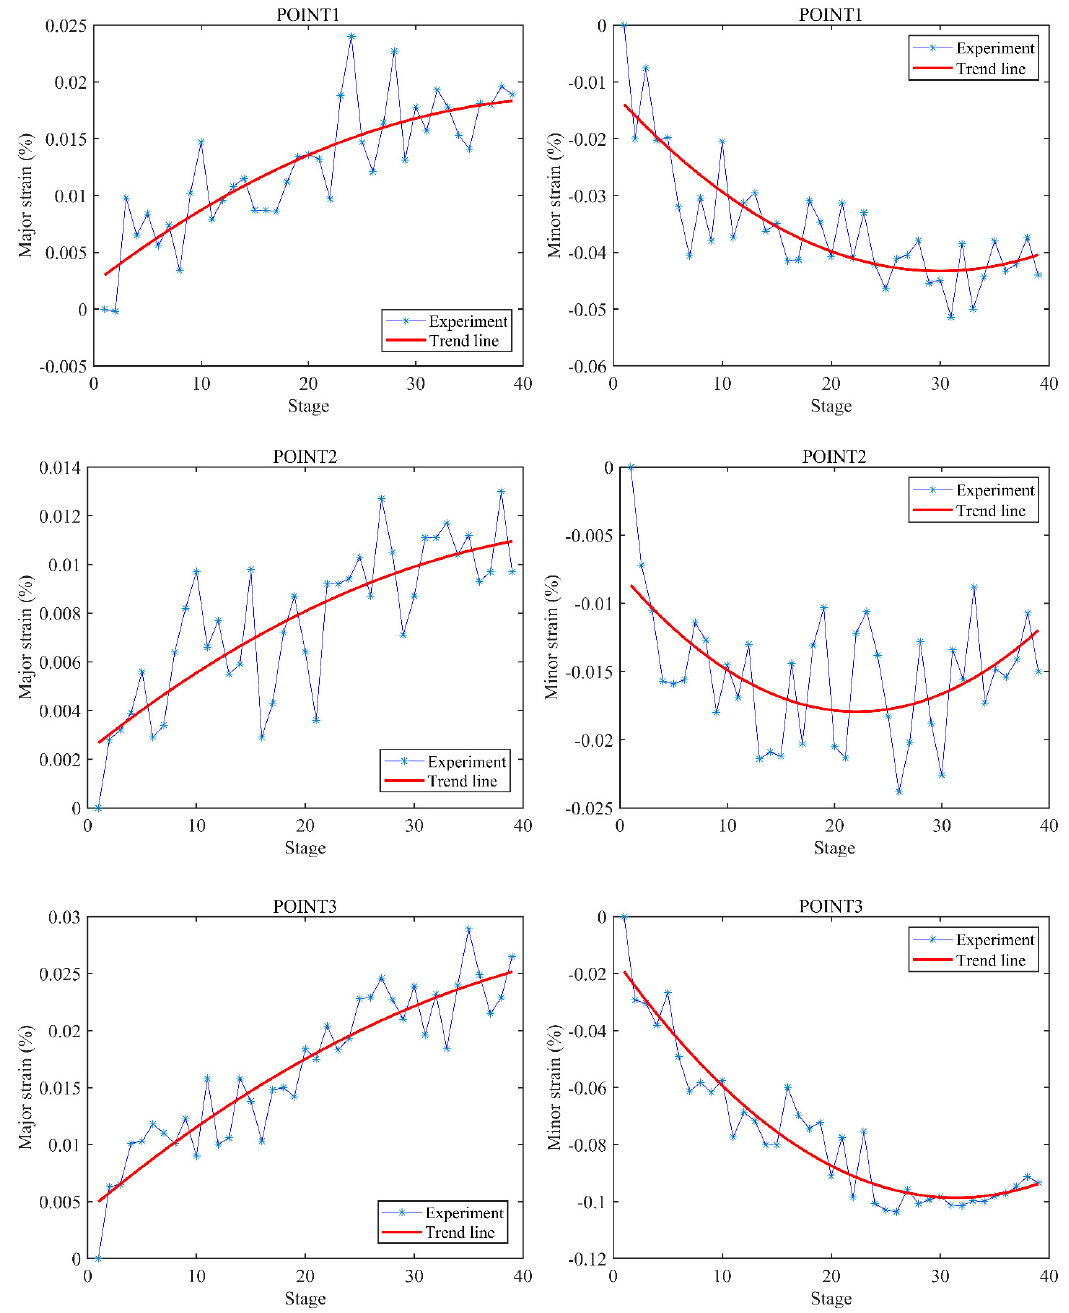
Figure 5. Stage–strain curves of three representative points (POINT1, POINT2, and POINT3, as shown in Figure 3) at the center line on the buccal surface of the specimen. The trend lines were fitted according to the experimental data.